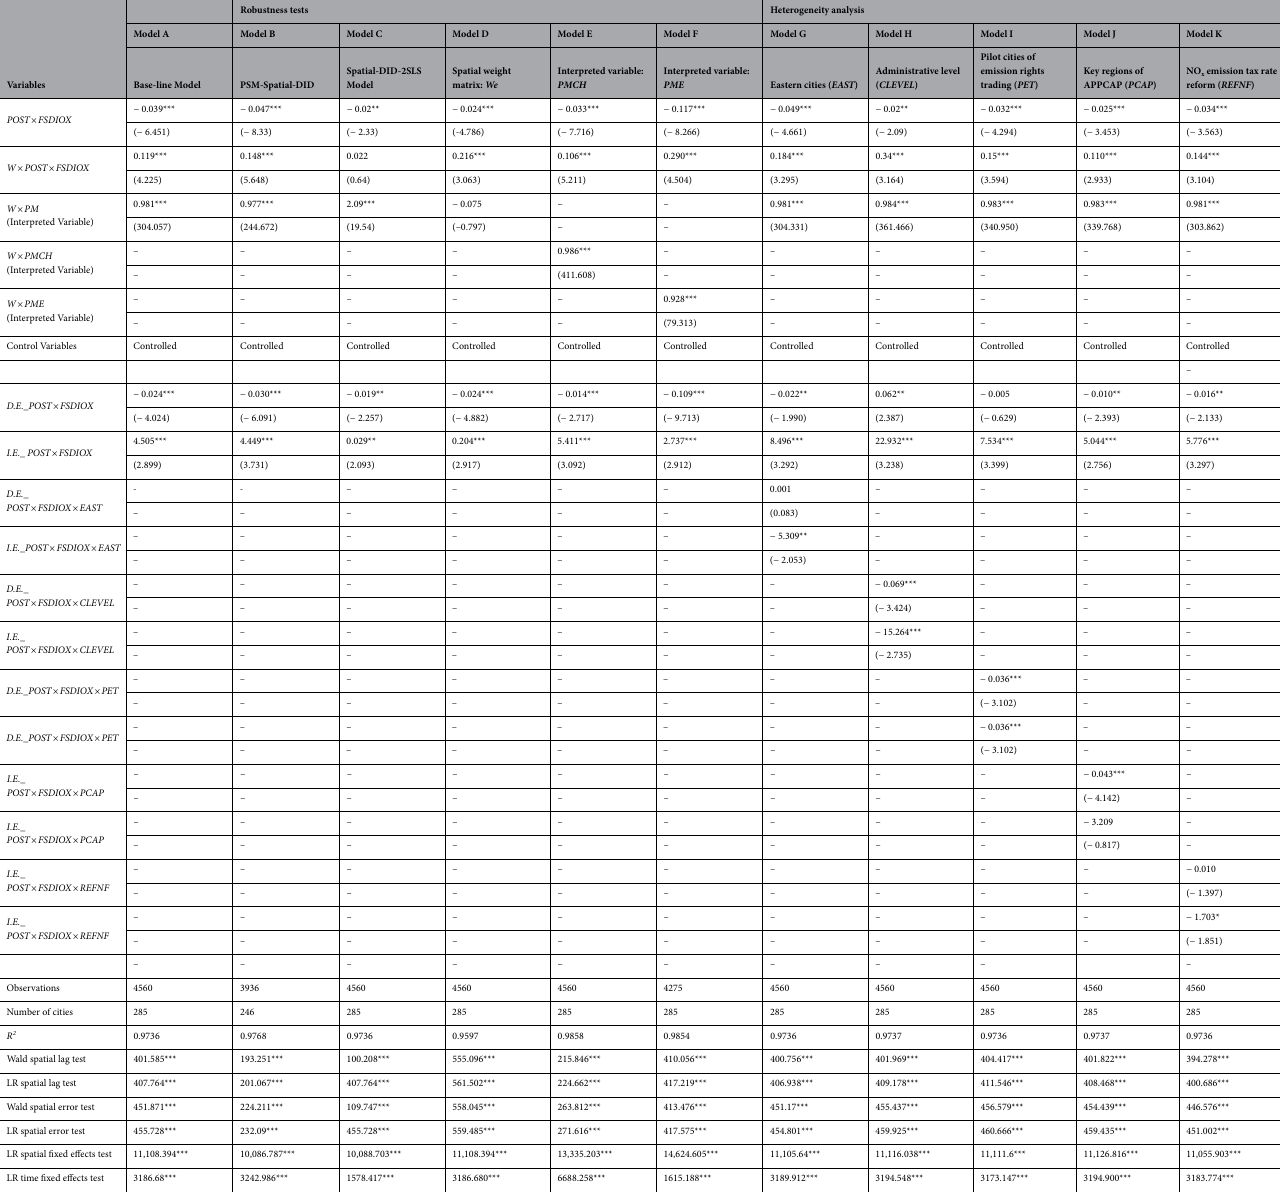
Table 2. Estimation results. Note: The t-statistics are marked in parentheses. *, **, and *** denote significance at 10%, 5%, and 1% levels, respectively. D.E. before the variable symbol indicates direct effect, and I.E. indicates indirect effect. The complete estimation results are reported in Table A.2 in the